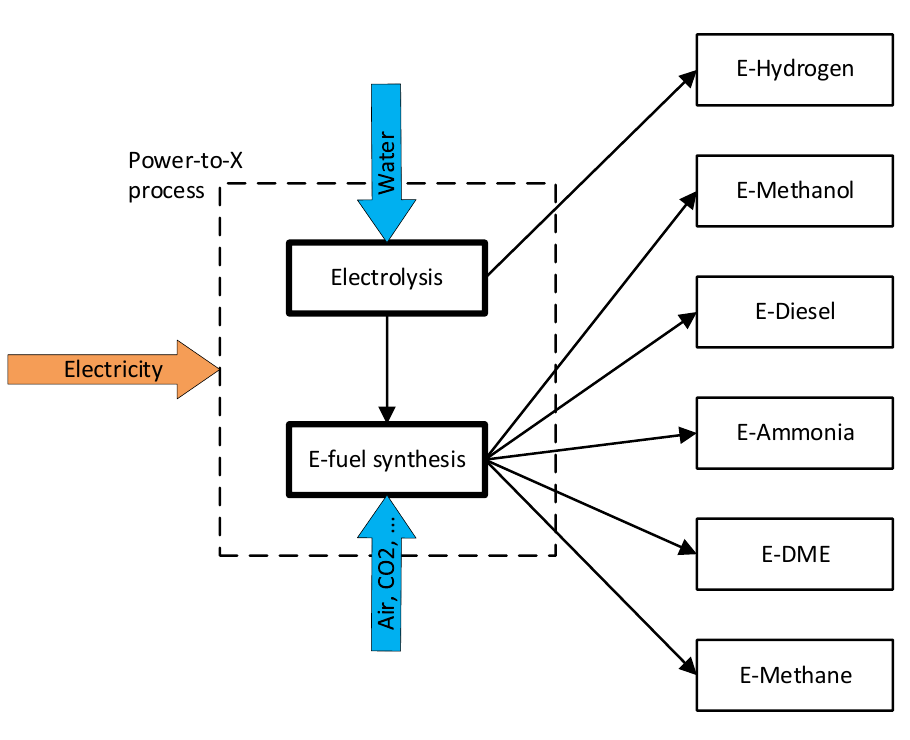
Figure 5. E-fuels production pathways.